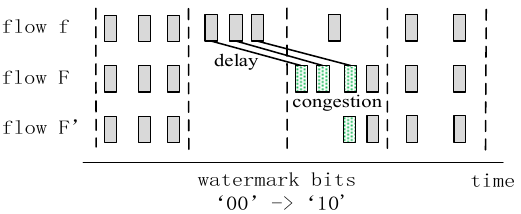
Figure 5. An example of the distortion of watermark ‘00’ when packet loss occurs.